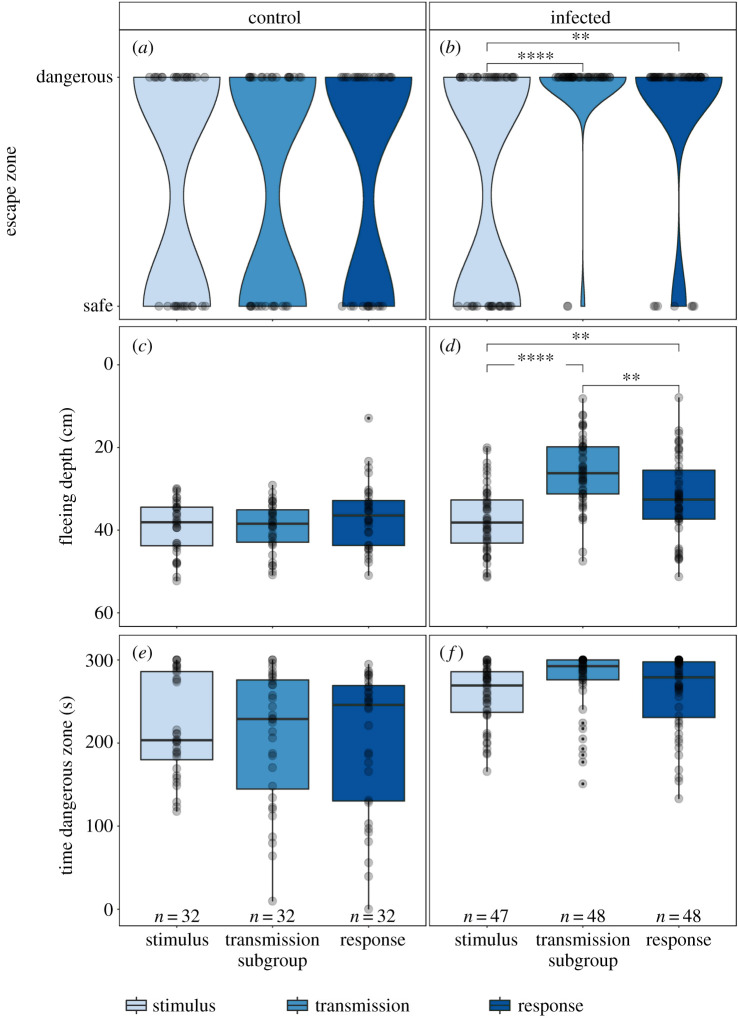
Escape responses of sticklebacks to an artificial bird strike (a,c,e) without (control) and (b,d,f) with S. solidus-infected conspecifics in the transmission group (infected). (a,b) Sticklebacks escaped to the safe zones at the bottom of the tanks or remained in the upper dangerous zones. The maximum width of the violins is scaled to be constant. (c,d) Maximum fleeing depth of sticklebacks after the bird strike. (e,f) Time spent in the dangerous zone. Results are shown per subgroup: stimulus (light blue), transmission (blue) and response (dark blue) subgroups. The edges of the box plots indicate the first and third quartiles; the solid lines the median, the whiskers the highest and lowest values within 1.5-fold of the inter-quartile range and the transparent dots represent all individual data points. (Online version in colour.)